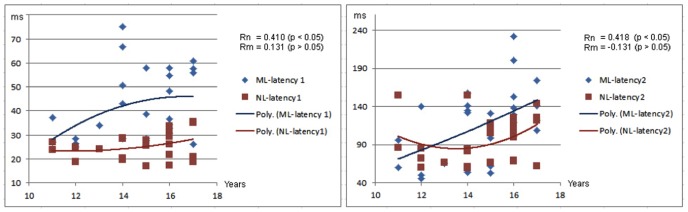
Correlation between age and responding latencies elicited by left finger movement.Two charts show the statistical correlation between age and latencies of movement-evoked magnetic fields (MEFs) from left finger movement. There are positive correlations between age and the latencies of MEFs in healthy controls. However, there is no significant correlation between age and the latencies of MEFs in children with migraine. The Y-axes are latencies of MEFs in milliseconds (ms); the X-axes are ages of children in years (Years). “ML” indicates children with migraine with left finger movement; “NL” indicates health controls with left finger movement. “Rn” indicates the correlation in health controls; “Rm” indicates the correlation in children with migraine.